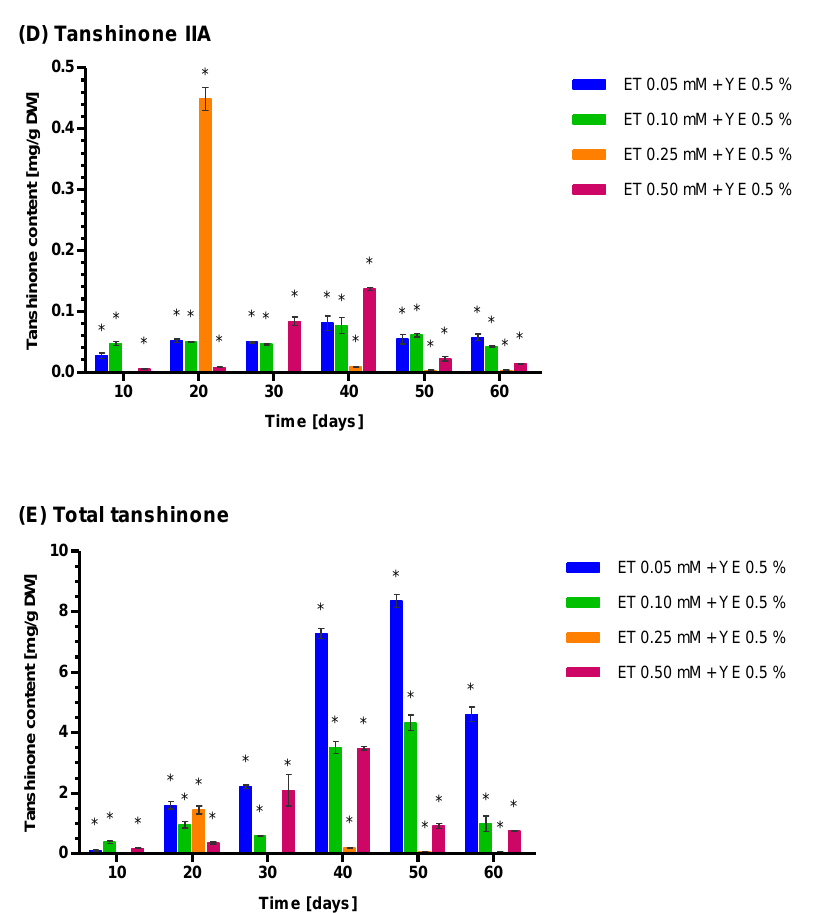
Figure 6. Concentration of four tanshinones dihydrotanshinone I ( A ), cryptotanshinone ( B ), tanshi- none I ( C ), tanshinone IIA ( D ), and total tanshinone ( E ) in S. miltiorrhiza callus presented as a function of yeast extract (YE) 0.5% combined with ethephon (ET) concentration (0.05, 0.10, 0.25, and 0.50 mM) and the elicitation time of 10–60 days. Control values were not detectable. Differences between control (0) and non-zero tested samples were statistically significant according to the Wilcoxon signed-rank test at p < 0.01. Significant results were marked by an asterisk (*).